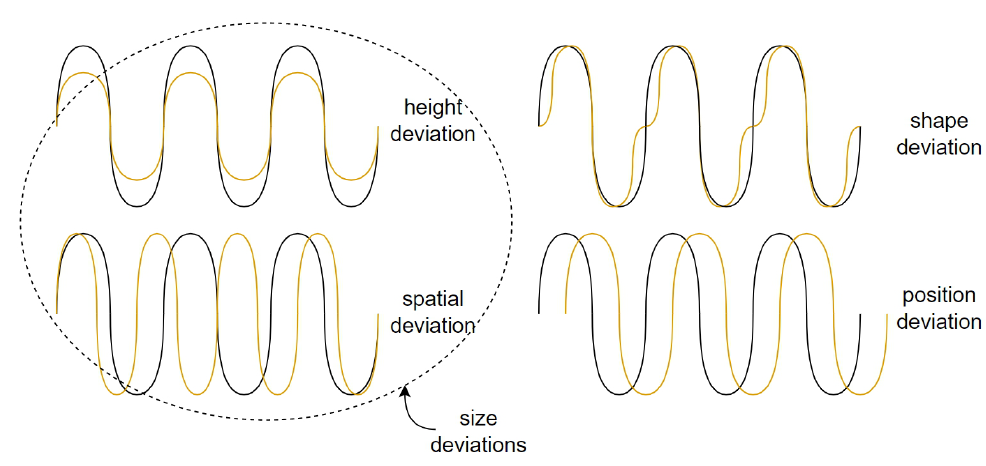
Figure 3. Types of texture